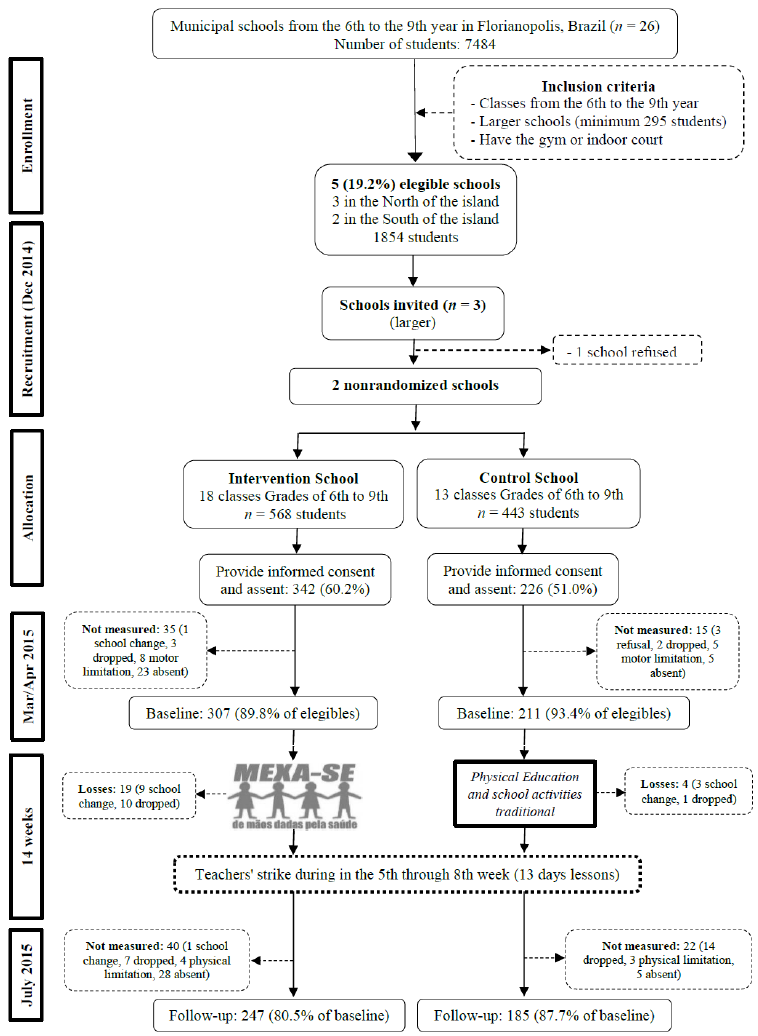
Figure 2. Flowchart of cardiorespiratory fitness. Florianopolis, Brazil, 2015. Mar: March; Apr: April; Dec: December.